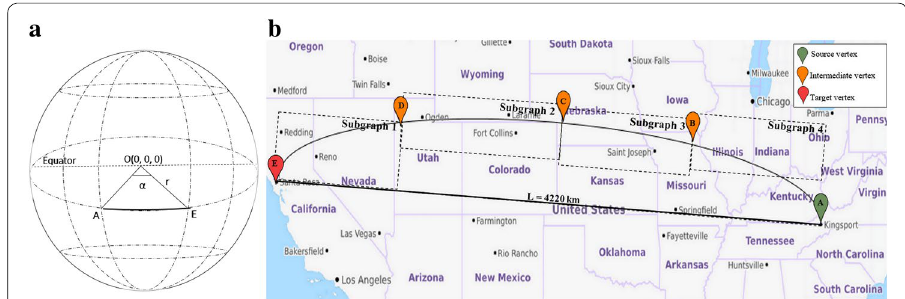
Fig. 5 Overall view of the path from A to E. a 3D view of the plan OAE on the the earth’s surface. b Travel from Kingsport (point A) to Santa Rosa (point E) with 2D view of OpenStreetMap. The graph is partitioned ⌢ into 4 subgraphs following the projected arc